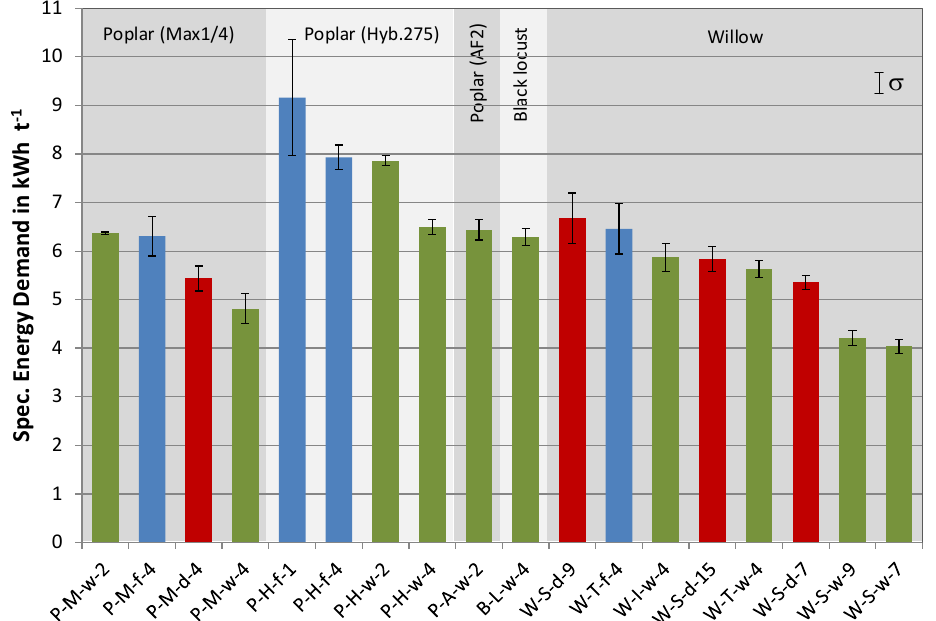
cross section area equivalent to four stems displayed the highest specific energy demand (9.16kWht trial P-H-f-1) measured in all the trials.